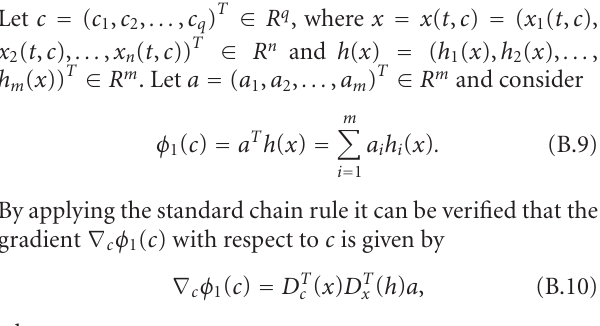
From definitions (A.3)–(A.5), it can be verified that, for u